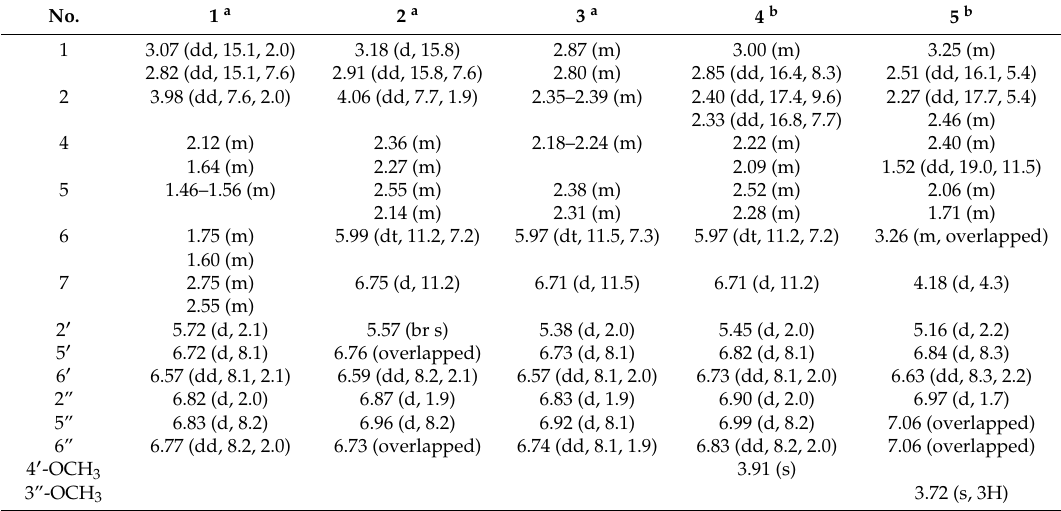
Table 1. The 1 H-NMR (600 MHz) data of compounds 1 – 5 , δ H in ppm (coupling type, J in